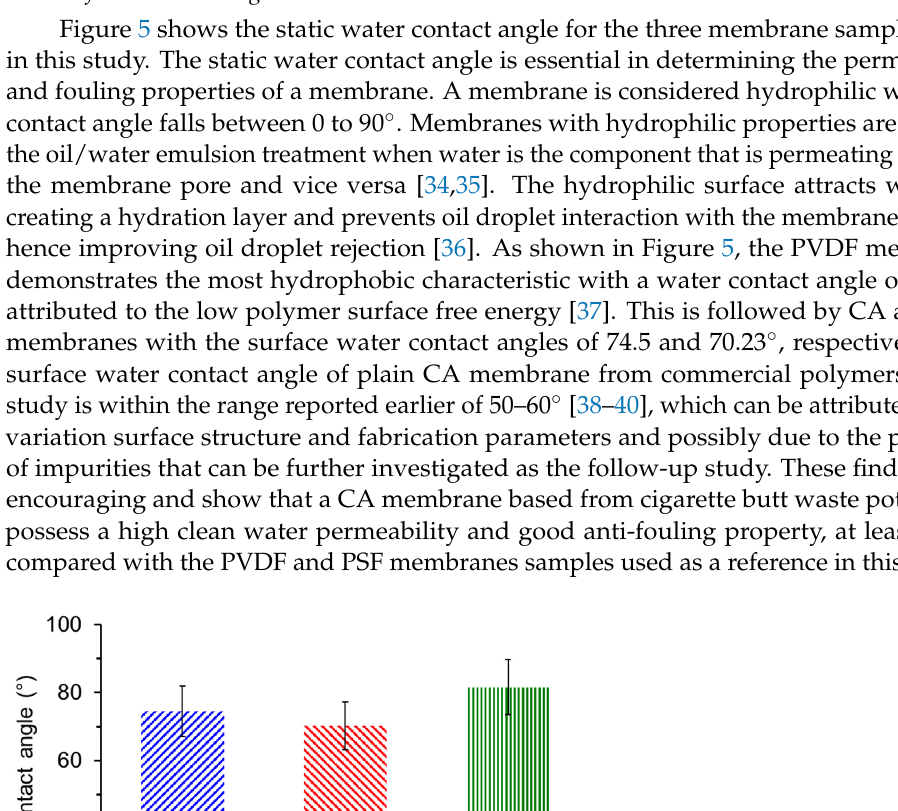
Figure 4. The mean pore size distribution of the cellulose acetate (CA), polysulfone (PSF), and polyvinylidene difluoride (PVDF) membranes.